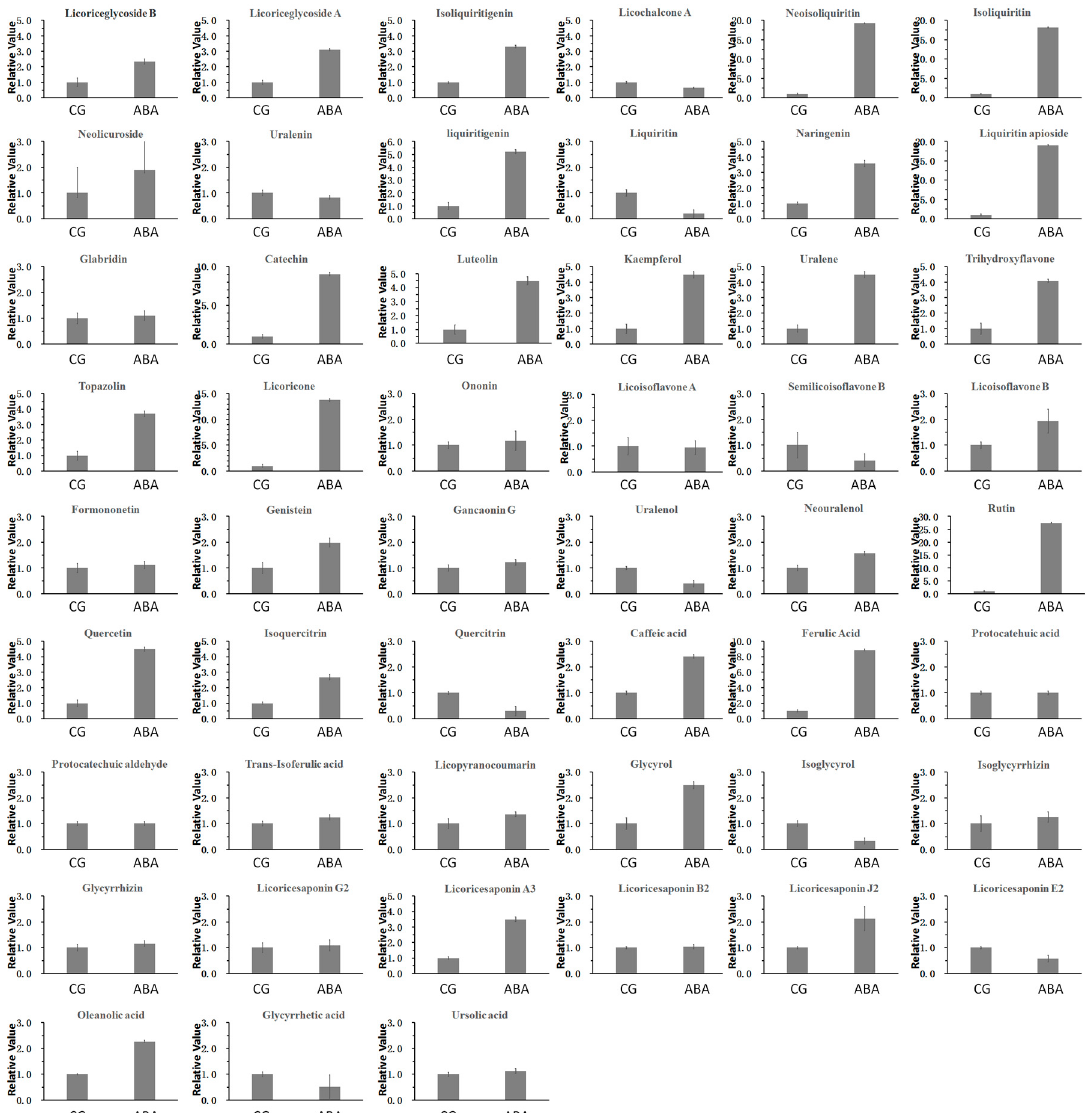
Figure 2. Analysis plot of the contents of 51 components in the two groups of licorice samples. ABA stands for ABA treatment group and CG stands for the control group.